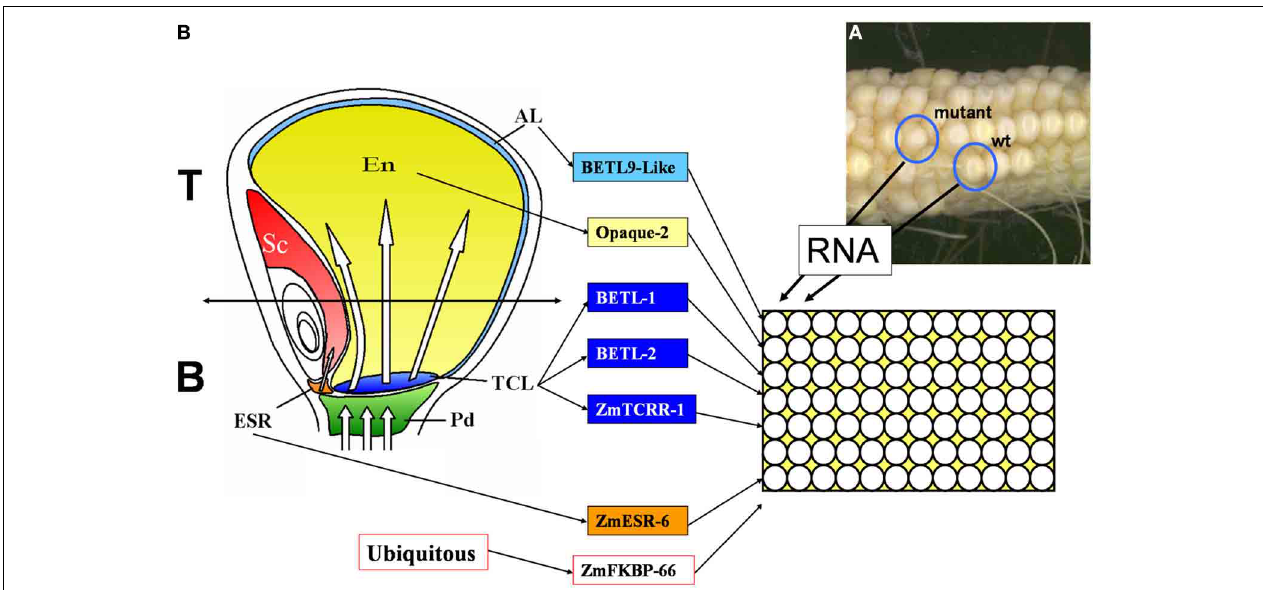
FIGURE 1 | Diagram describing the setup of the qRT-PCR screening used in this work. (A) Image of a cob segregating for WT and miniature mutant phenotypes, source for the current study. (B) Sagittal section of a 15 DAP maize kernel showing the different tissular domains it contains. Pd, pedicel; ESR, embryo surrounding region; TCL, transfer cell layer; Em, embryo; En,